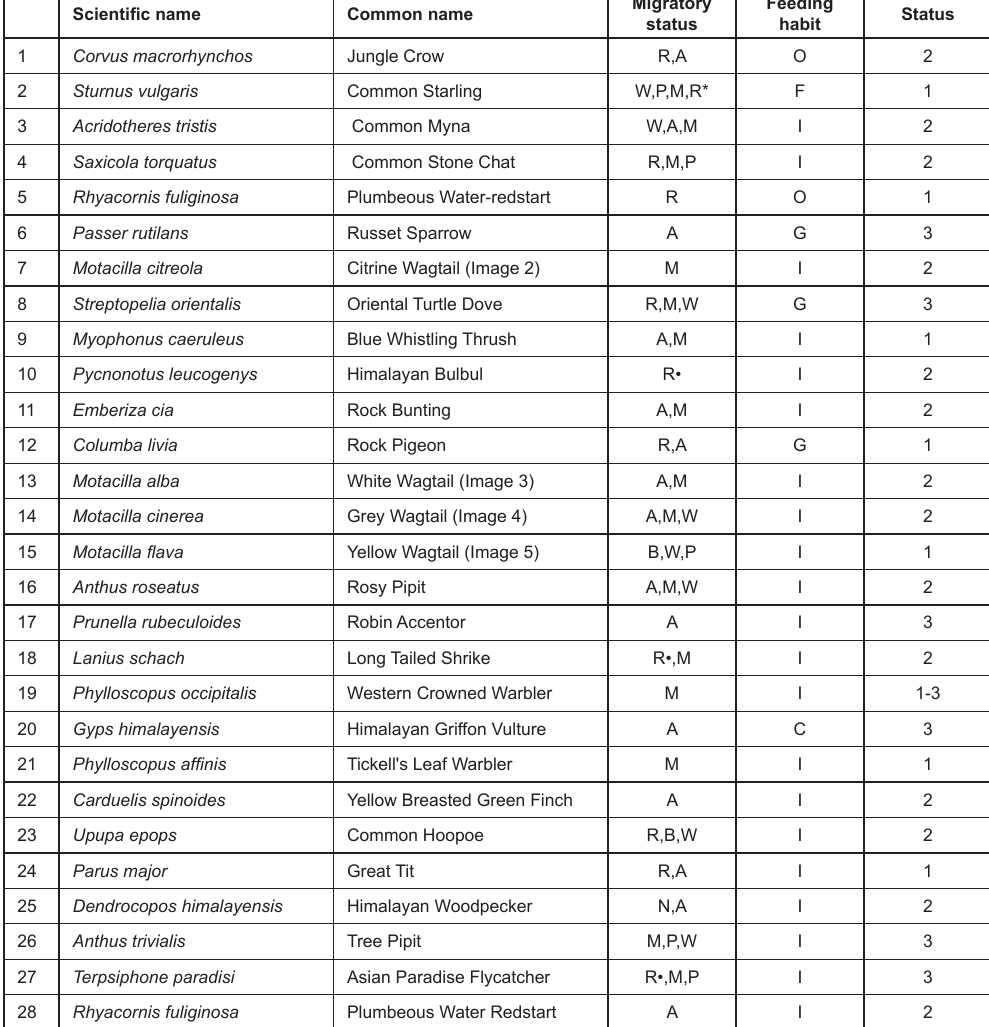
Table 1. The migratory status, feeding habits, abundance and status of avifauna of Overa-Aru Wildlife